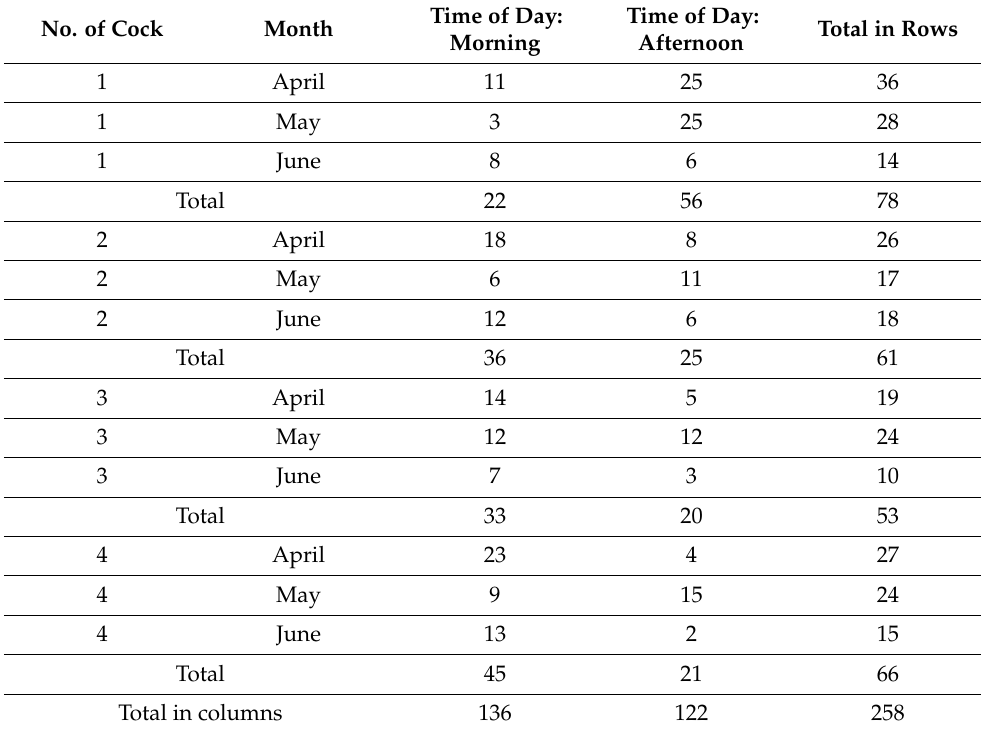
Table 1. The number of vocalizations in the different months and time of day. No. of